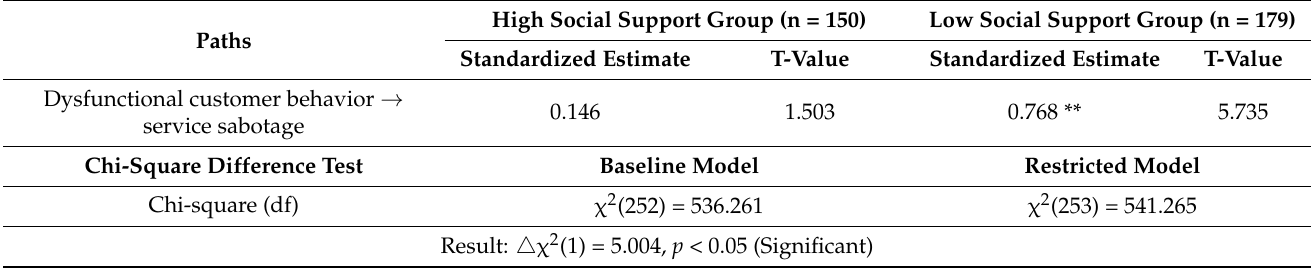
Table 4. Moderating test